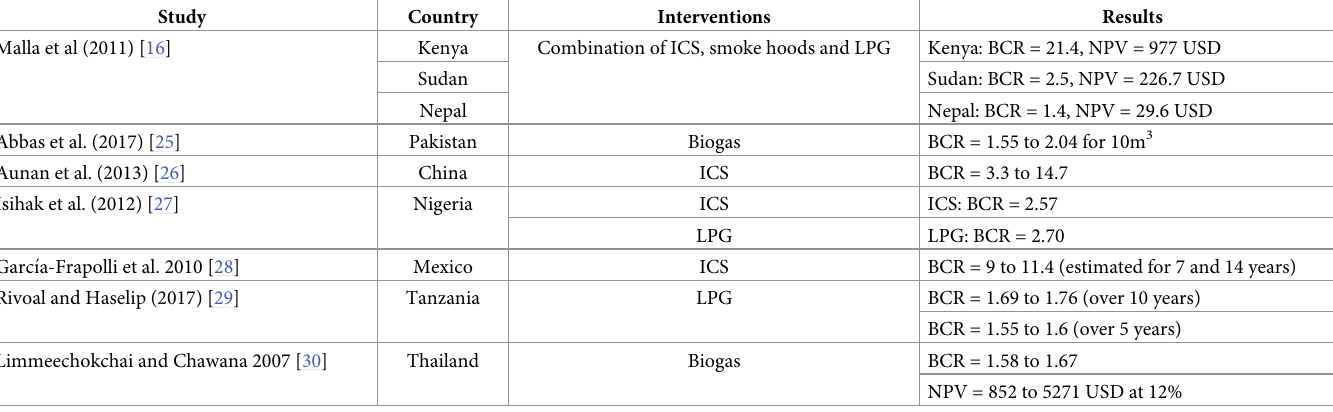
Table 1. Summary of estimated benefit-cost ratios for IAP interventions in previous